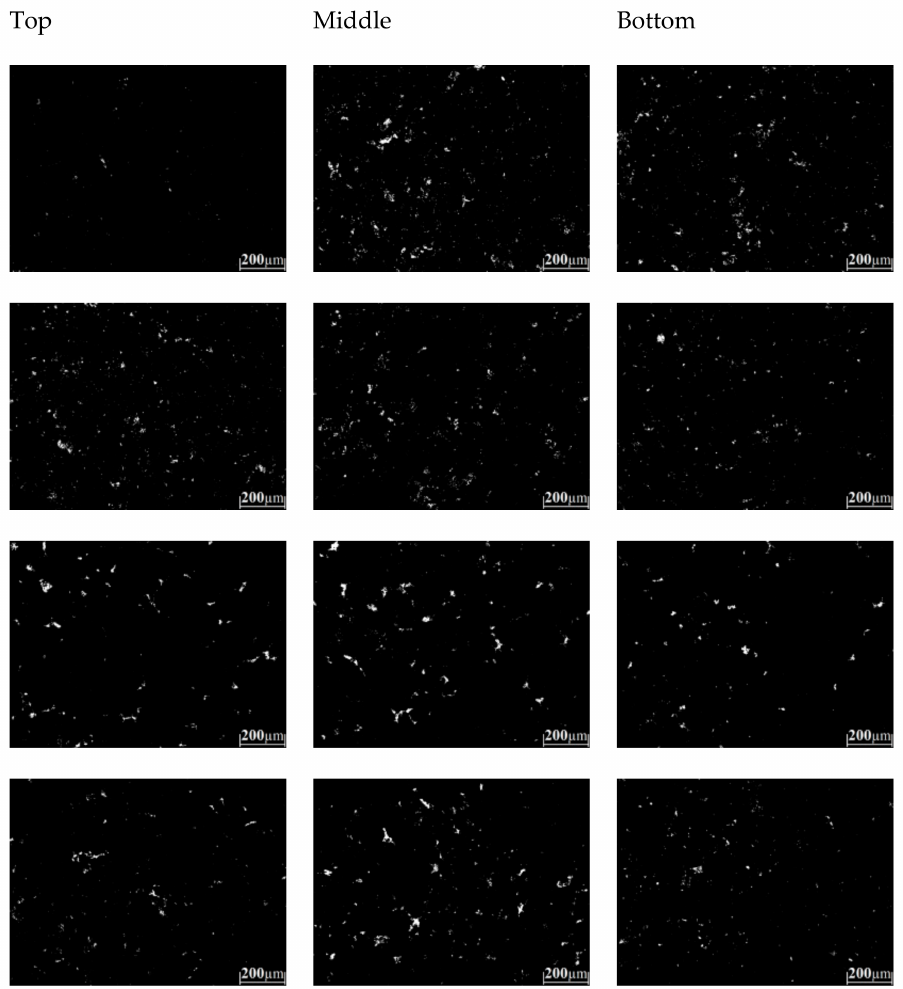
Figure A7. Etched microstructure with ammonium persulfate reveals the carbides phase (white regions) of the ductile iron alloyed with 0.3 wt % V for different lobes and